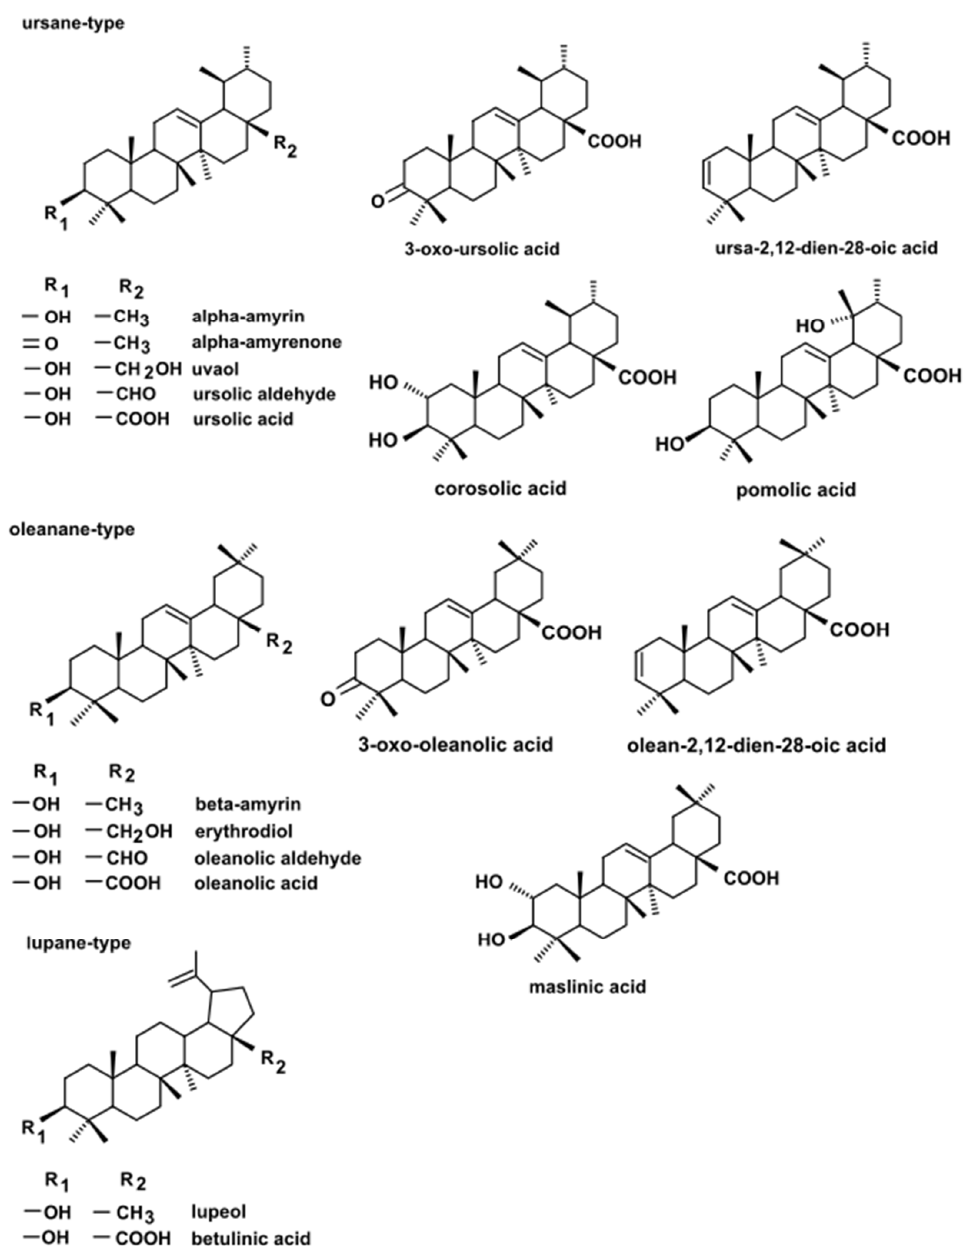
Figure 2. The chemical structures of ursane-, oleanane-, and lupane-type triterpenoids identified in this study.